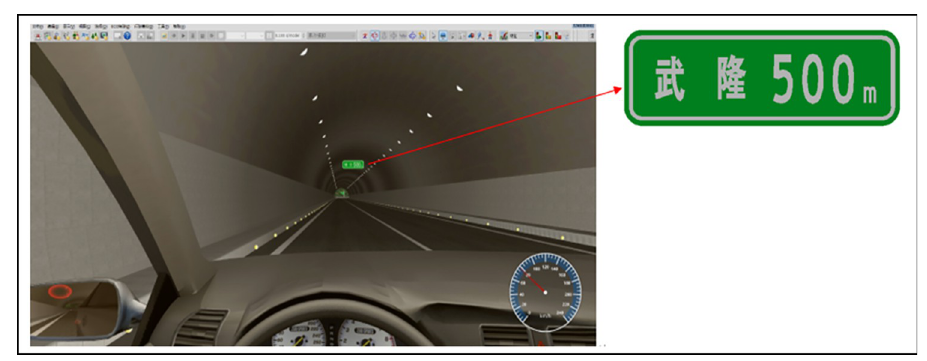
Fig 6. Driving simulation scenario.